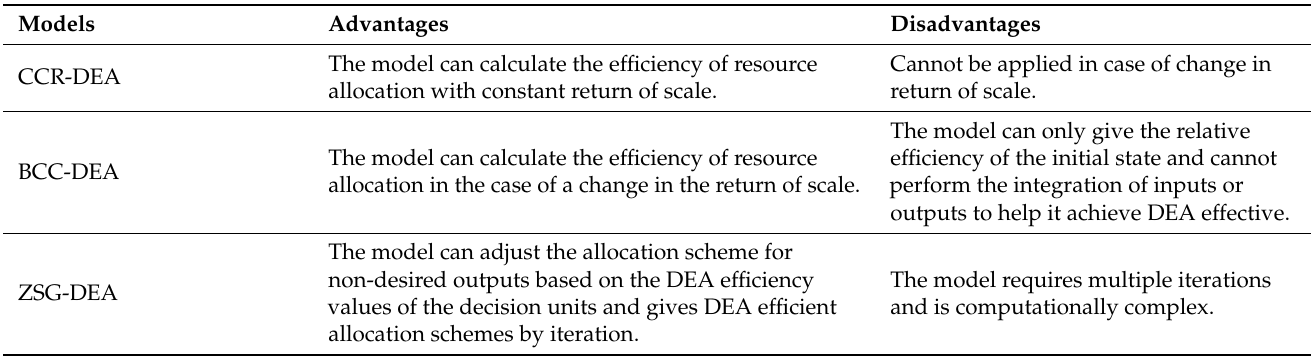
Table 2. Major DEA models and their advantages and